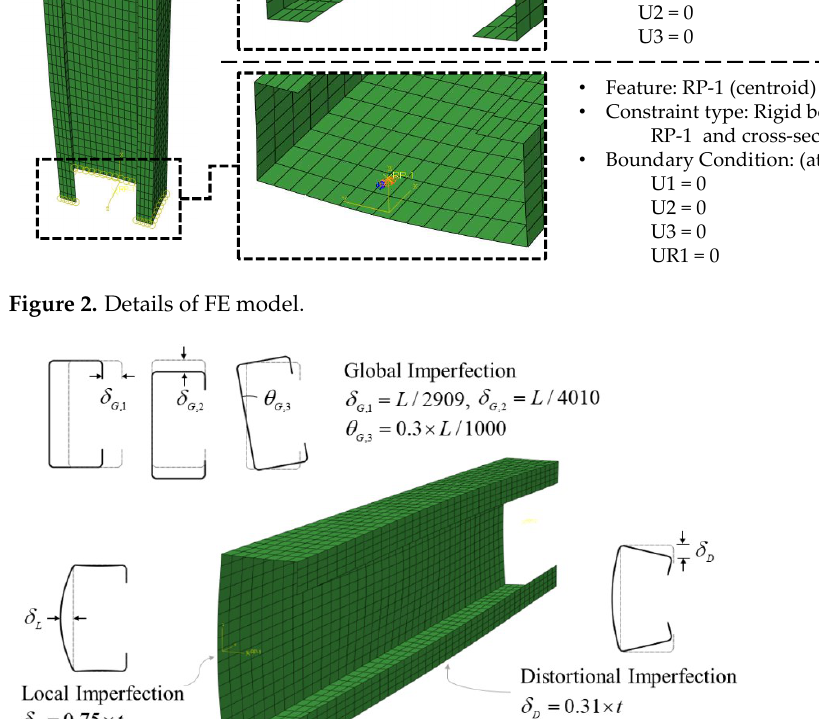
Figure 3. Initial imperfection definition.